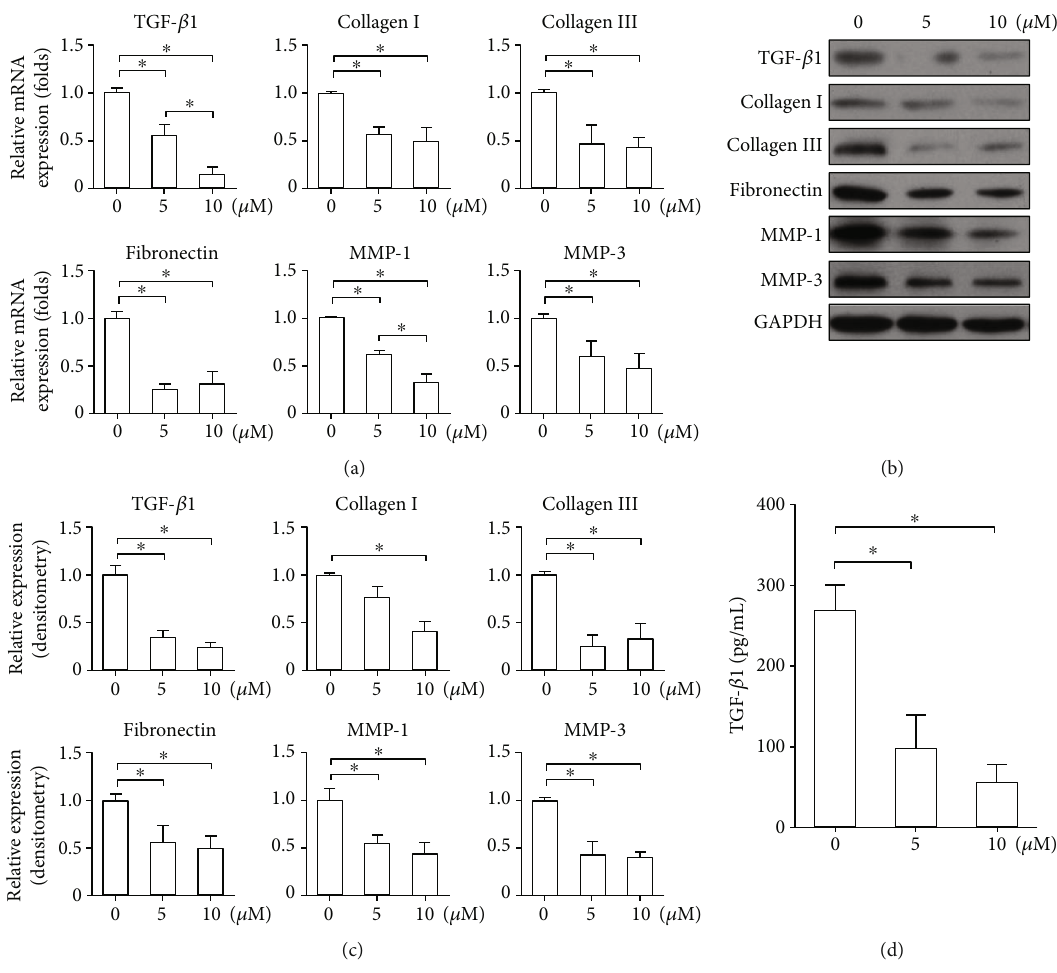
Figure 1: LY2109761 inhibits the expression of keloid-derived fi broblast-related factors in vitro. (a) Relative mRNA expression levels of transforming growth factor (TGF)- β 1, collagens I and III, fi bronectin, and matrix metalloprotease- (MMP-) 1, and MMP-3 as determined by qRT-PCR. (b) Representative western blots showing protein expression of the above gene products. (c) Relative protein expression. (d) ELISA results showing TGF- β 1 secretion in response to increasing concentrations of LY2109761. Glyceraldehyde 3-phosphate dehydrogenase (GADPH) was used as the internal control. ∗ P < 0 : 05 between LY2109761 groups and DMSO control; ∗∗ P < 0 : 05 between LY2109761 5 μ M and 10 μ M treatment